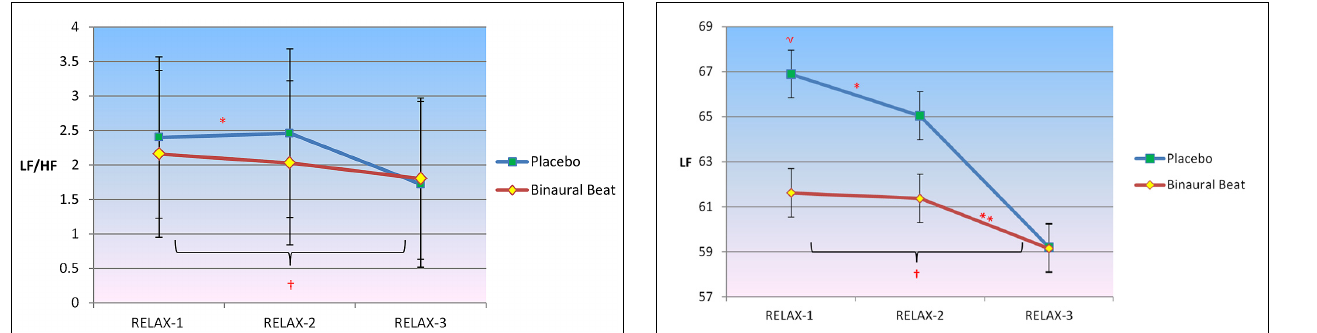
FIGURE 2 | Differences in sympathovagal balance (i.e., LF/HF) between binaural-beat and placebo conditions. Error bars represent ± 1 SE of the marginal mean. *Condition × Time interaction is significant at p < 0.05. † Simple main effect ofTime is significant at p < 0.05 (for binaural-beat condition only). *Interaction is significant at p < 0.05.